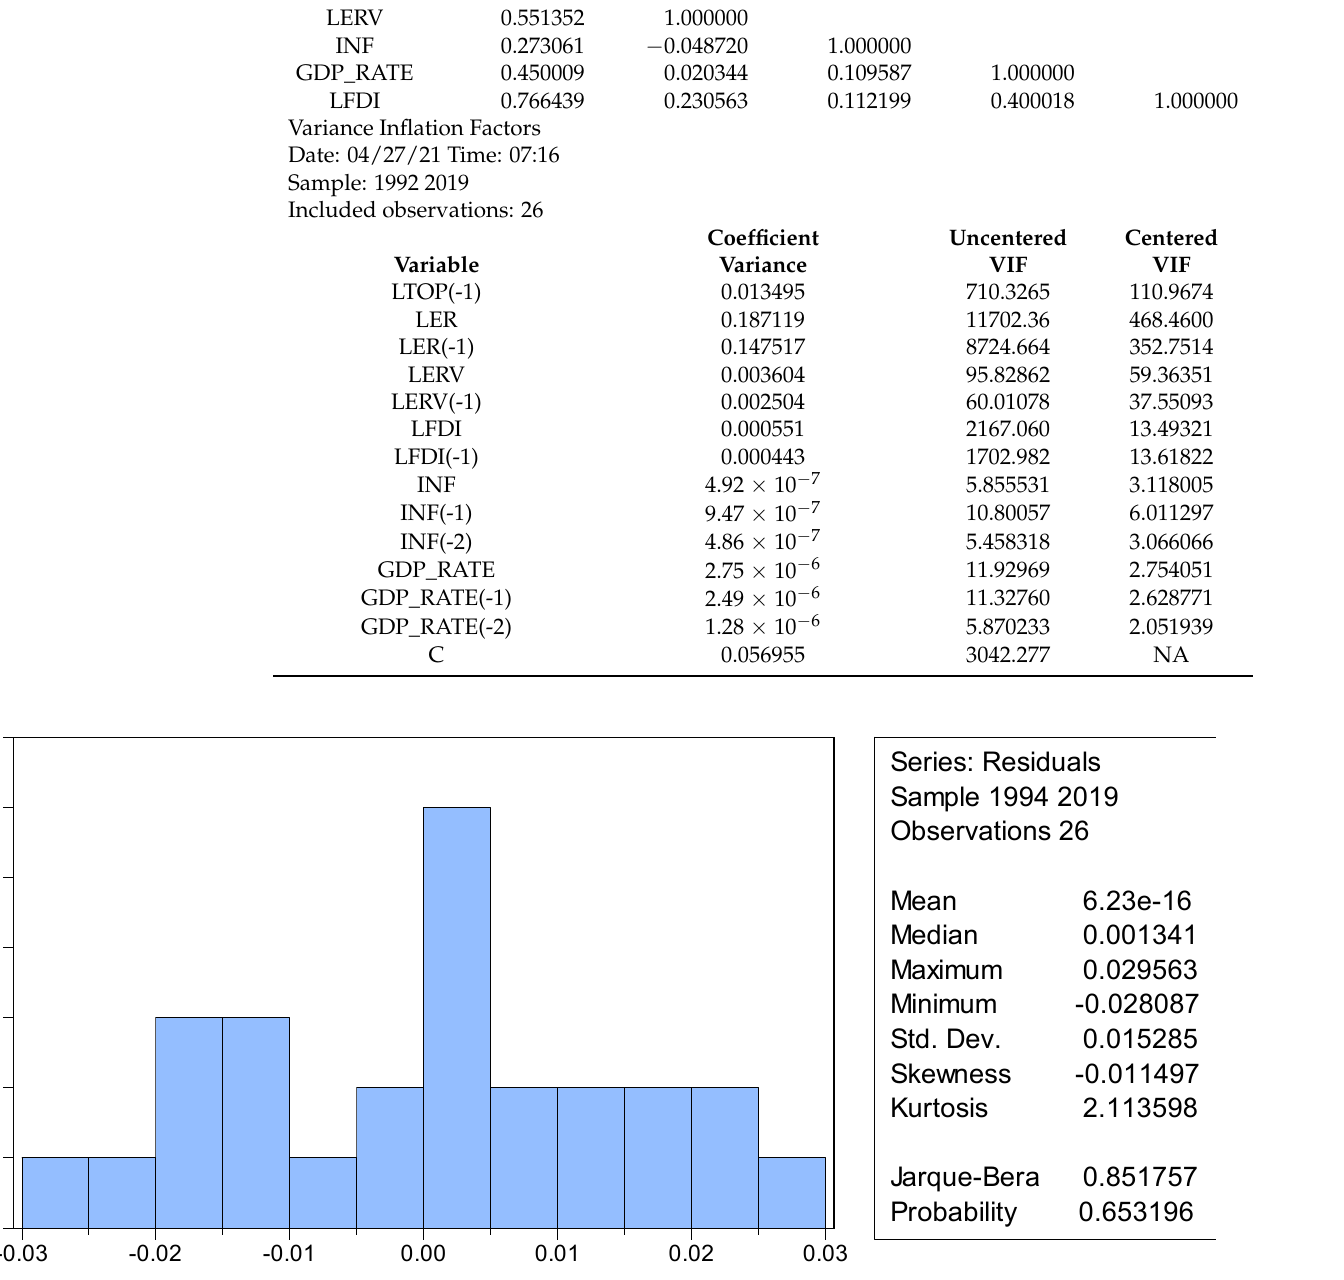
Table A3. Heteroscedasticity test result. Heteroscedasticity Test: Breusch-Pagan-Godfrey F-statistic